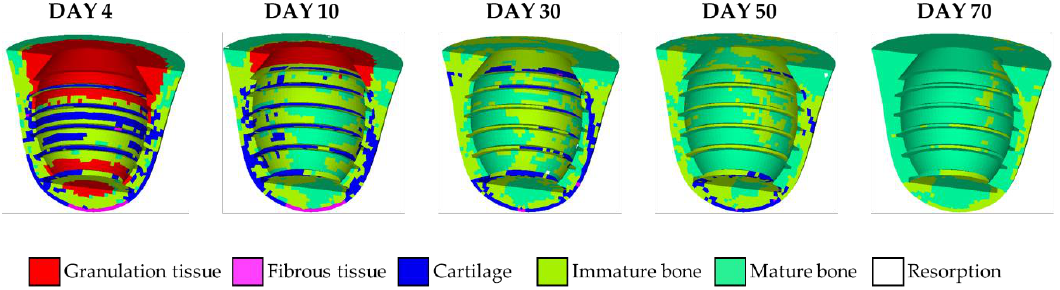
Figure 7. The tissue differentiation history predicted by the mechano-regulation algorithm in higher bone strength case.